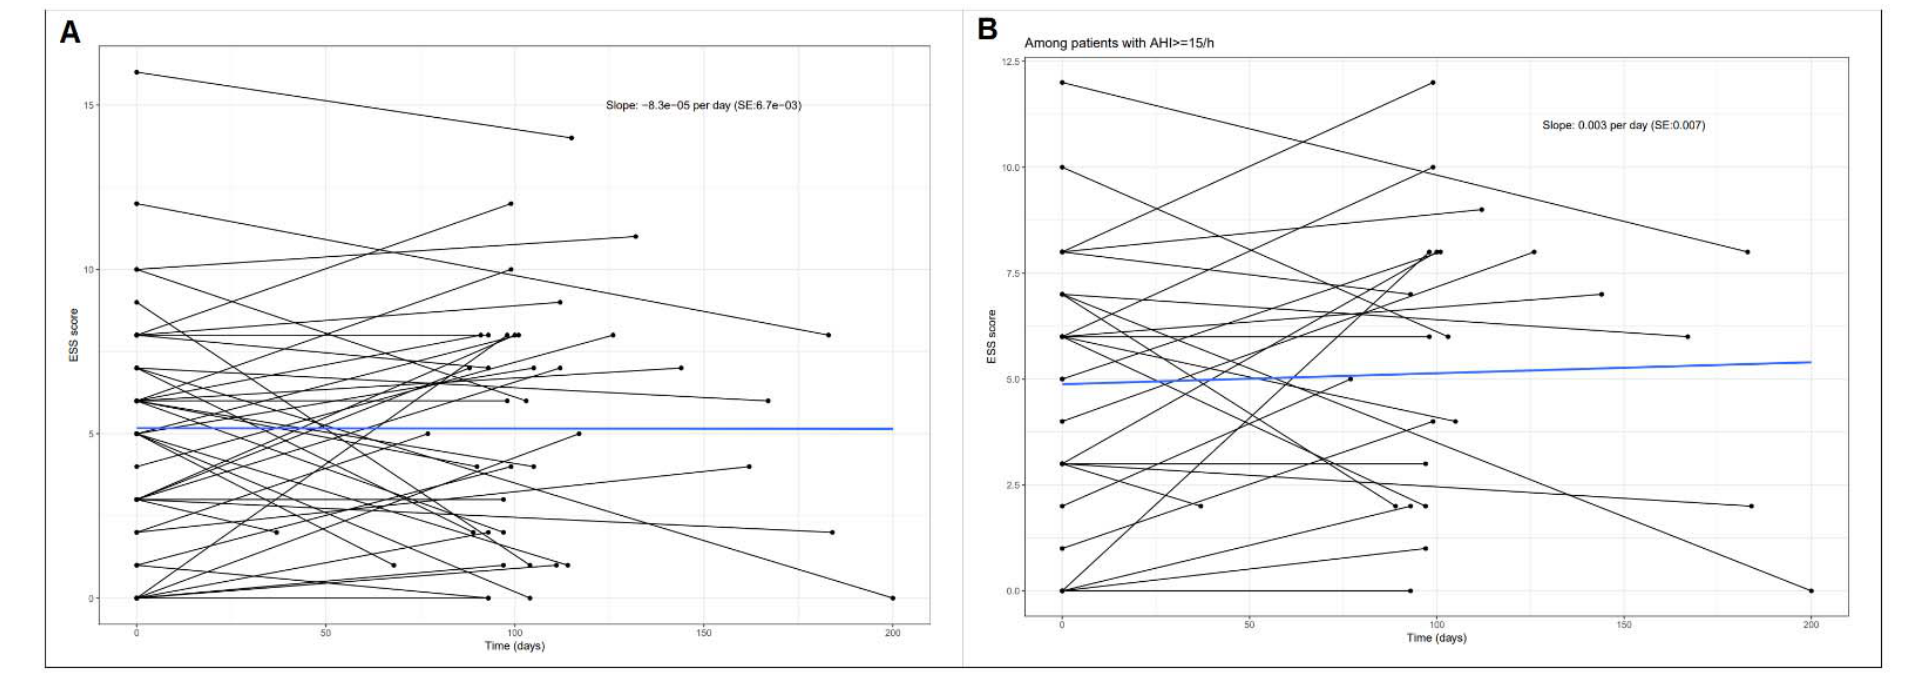
Figure 4. Progression of Epworth Sleepiness Scale (ESS) during follow-up in 34 patients. ( A ) In all patients ( p = 0.999). ( B ) In patients with baseline-AHI ≥ 15 ( p = 0.636).